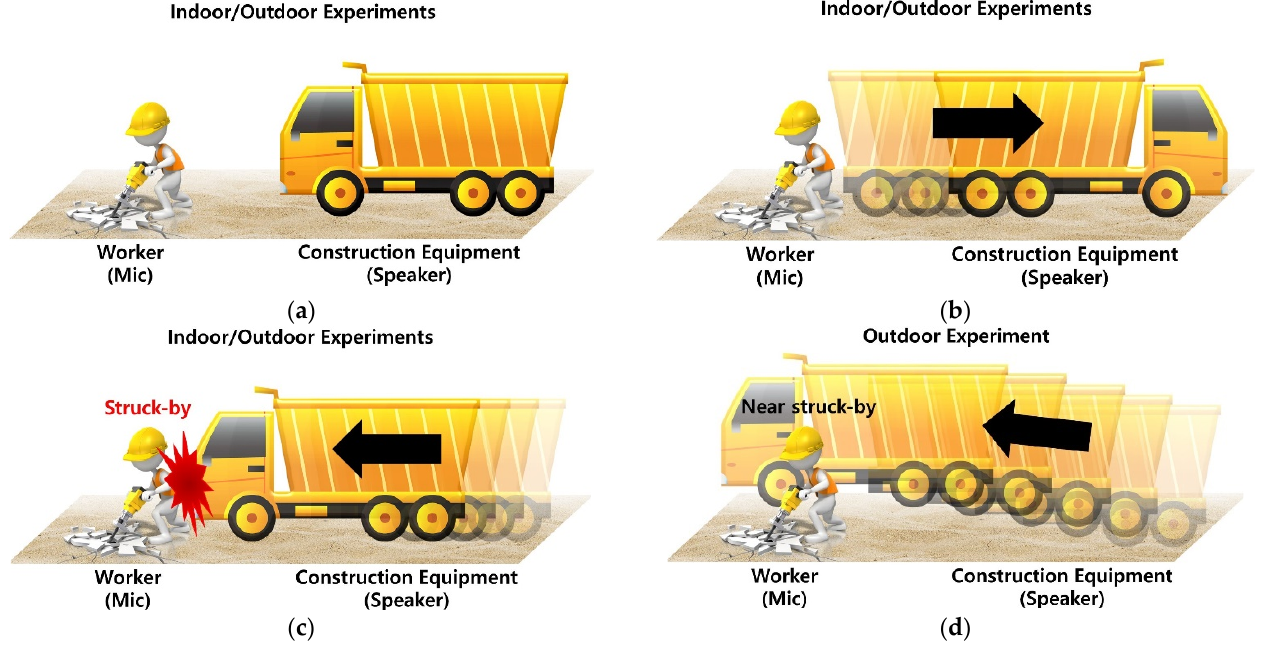
Figure 2. Data Collection Scenarios: ( a ) Stationary Object, ( b ) Moving Backward, ( c ) Moving Forward (struck-by accident), ( d ) Moving Forward (near-miss situation).